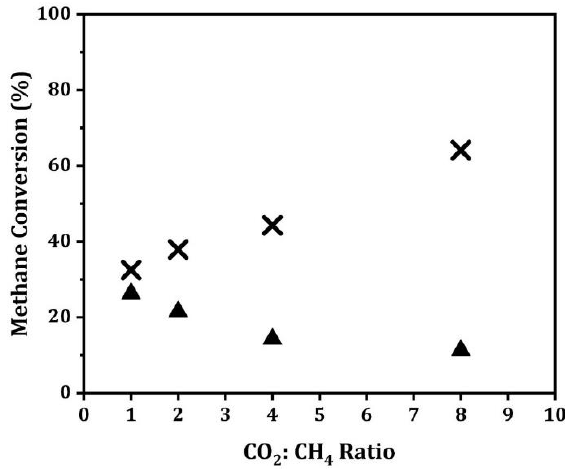
Figure 7. Methane conversion for MDR reaction at 873K for ( × ) Ni / MgAl 2 O 4 and ( ▲ ) Ni / CaTiO 3 / MgAl 2 O 4 as a function of CO 2 :CH 4 ratio. The total flow rate and the methane flow rate were controlled at 120 mL / min and 5 mL / min, respectively, while He and CO 2 flows were adjusted accordingly to achieve the desired ratios. The loading is 100 mg for Ni / MgAl 2 O 4 and 200 mg for Ni / CaTiO 3 / MgAl 2 O 4 in order to ensure similar starting point for the methane conversion. Both of the samples were reduced at 1073K prior to catalytic measurements.